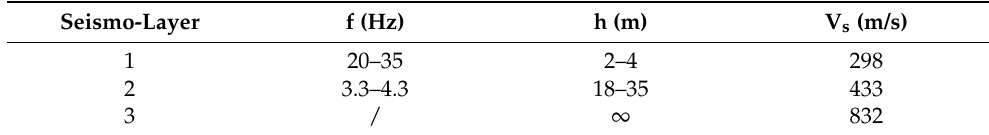
Figure 4. ( a ) Location of H/V measurements divided into two groups defined as A and B. ( b ) H/V curves of group A recorded near the crown. ( c ) H/V curves of group B recorded on the landslide body. Table 1. Values of f (frequency), depth (h) and mean S-wave velocity (Vs) for each of the seismo-layers identified by the HVSR analysis.